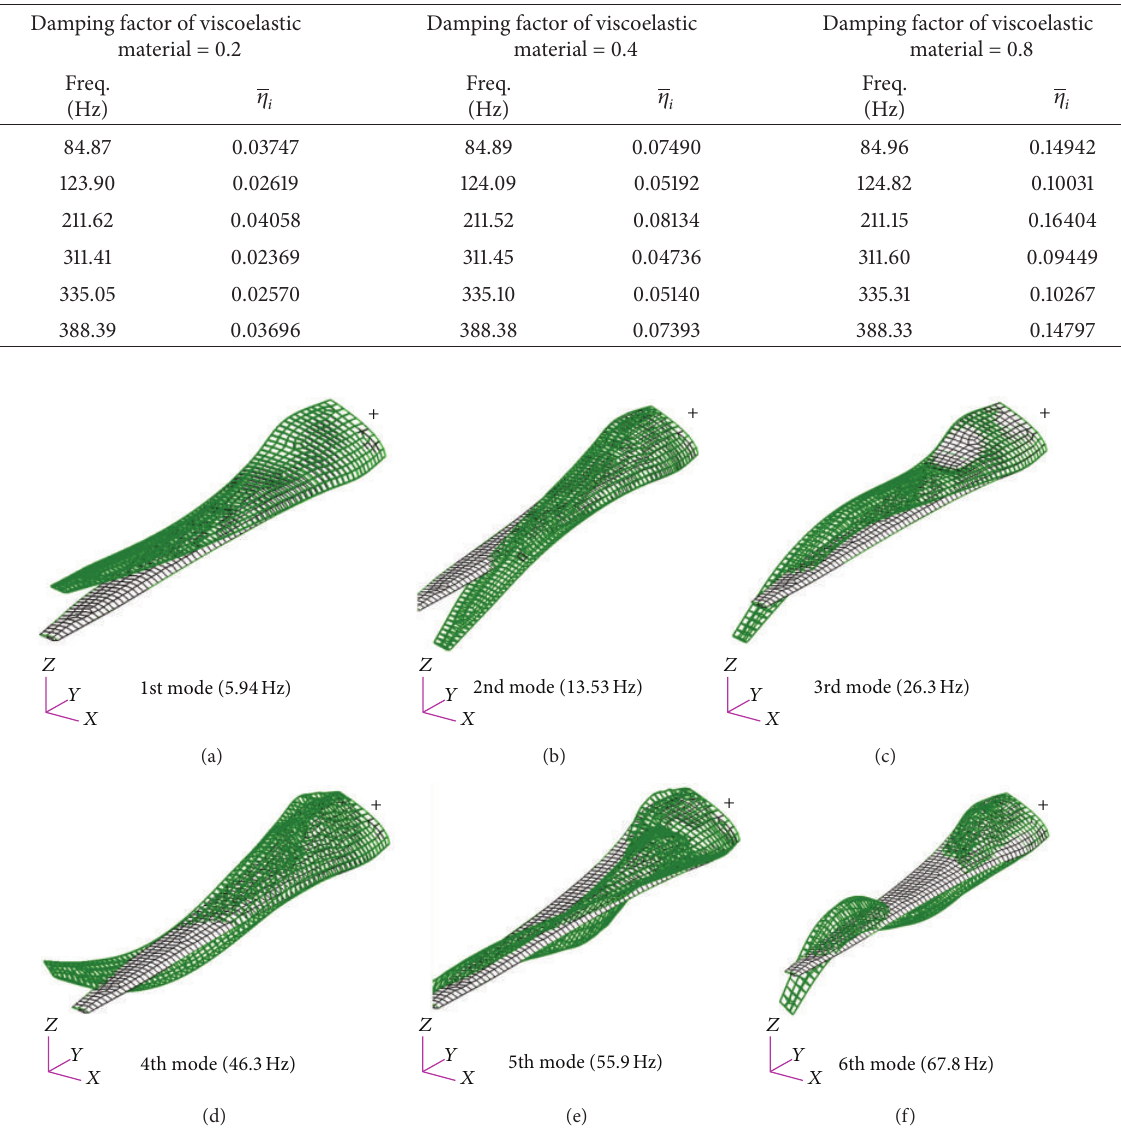
Table 3: Comparison of natural frequencies and loss factors of composite laminated clamped free shell structure.